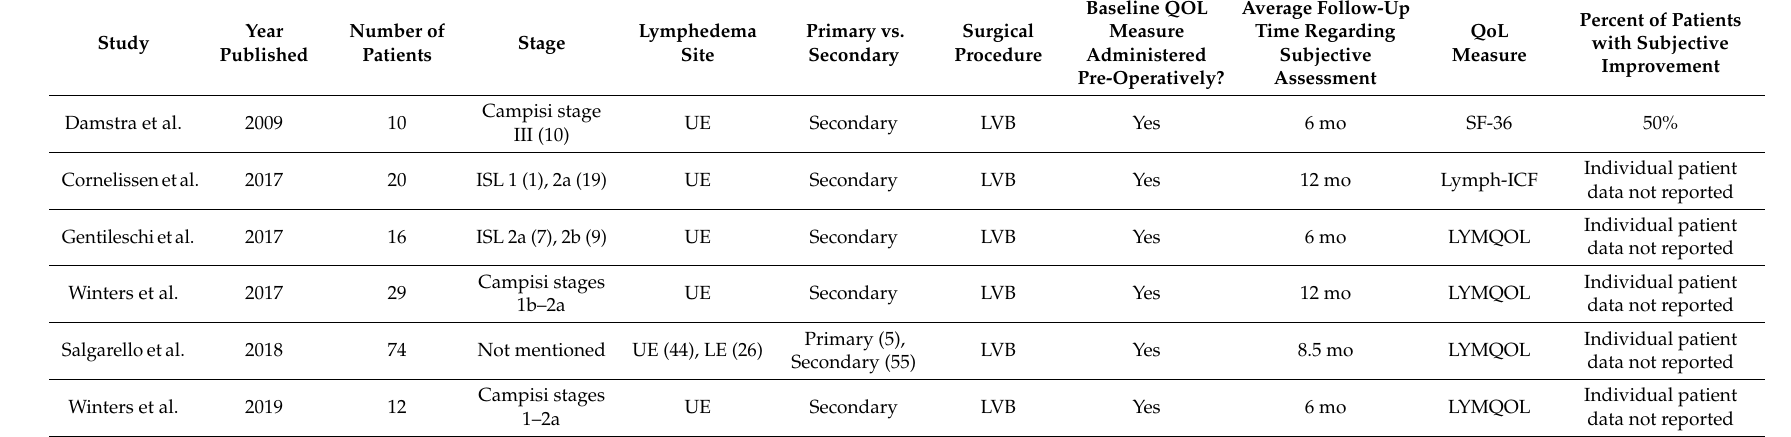
Table 3. QOL in LVB using validated tools.